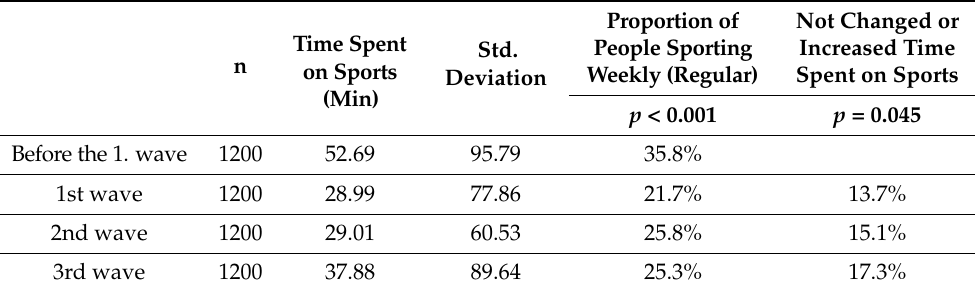
Table 3. Changes in sporting habits during the different waves of the COVID-19 pandemic. Time Spent Std. People Sporting n